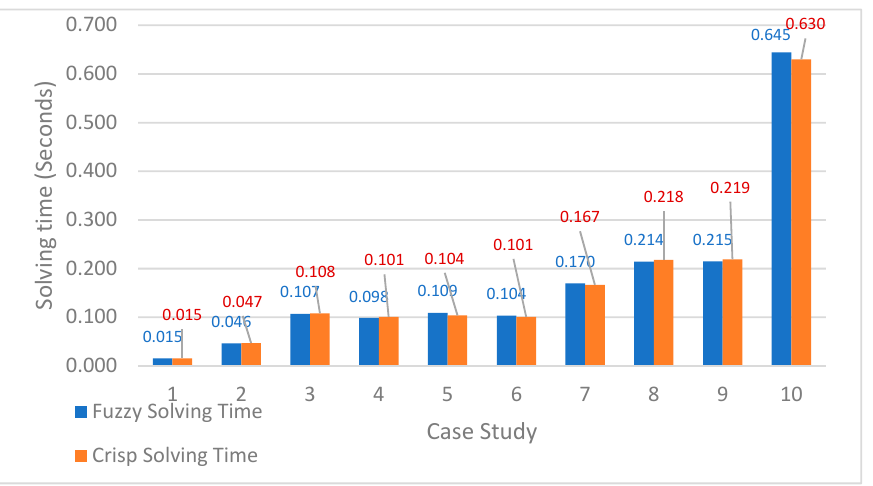
Figure 24. Comparing solving time of the crisp TOPSIS heuristic and fuzzy–TOPSIS heuristic.